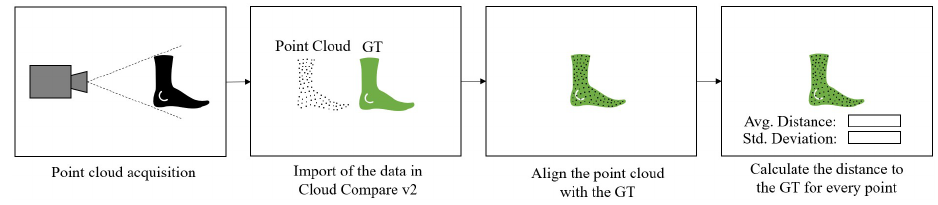
Figure 13. Experimental procedure for the overall shape reconstruction.